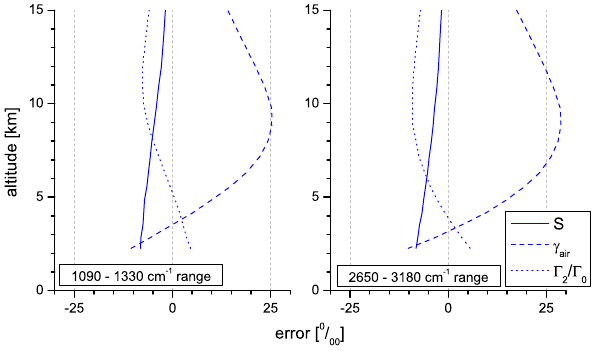
Fig. 10. Same as Fig. 8 but for δ D and the two retrievals at 1090 - 1330 and 2650 - 3180 cm − 1 .